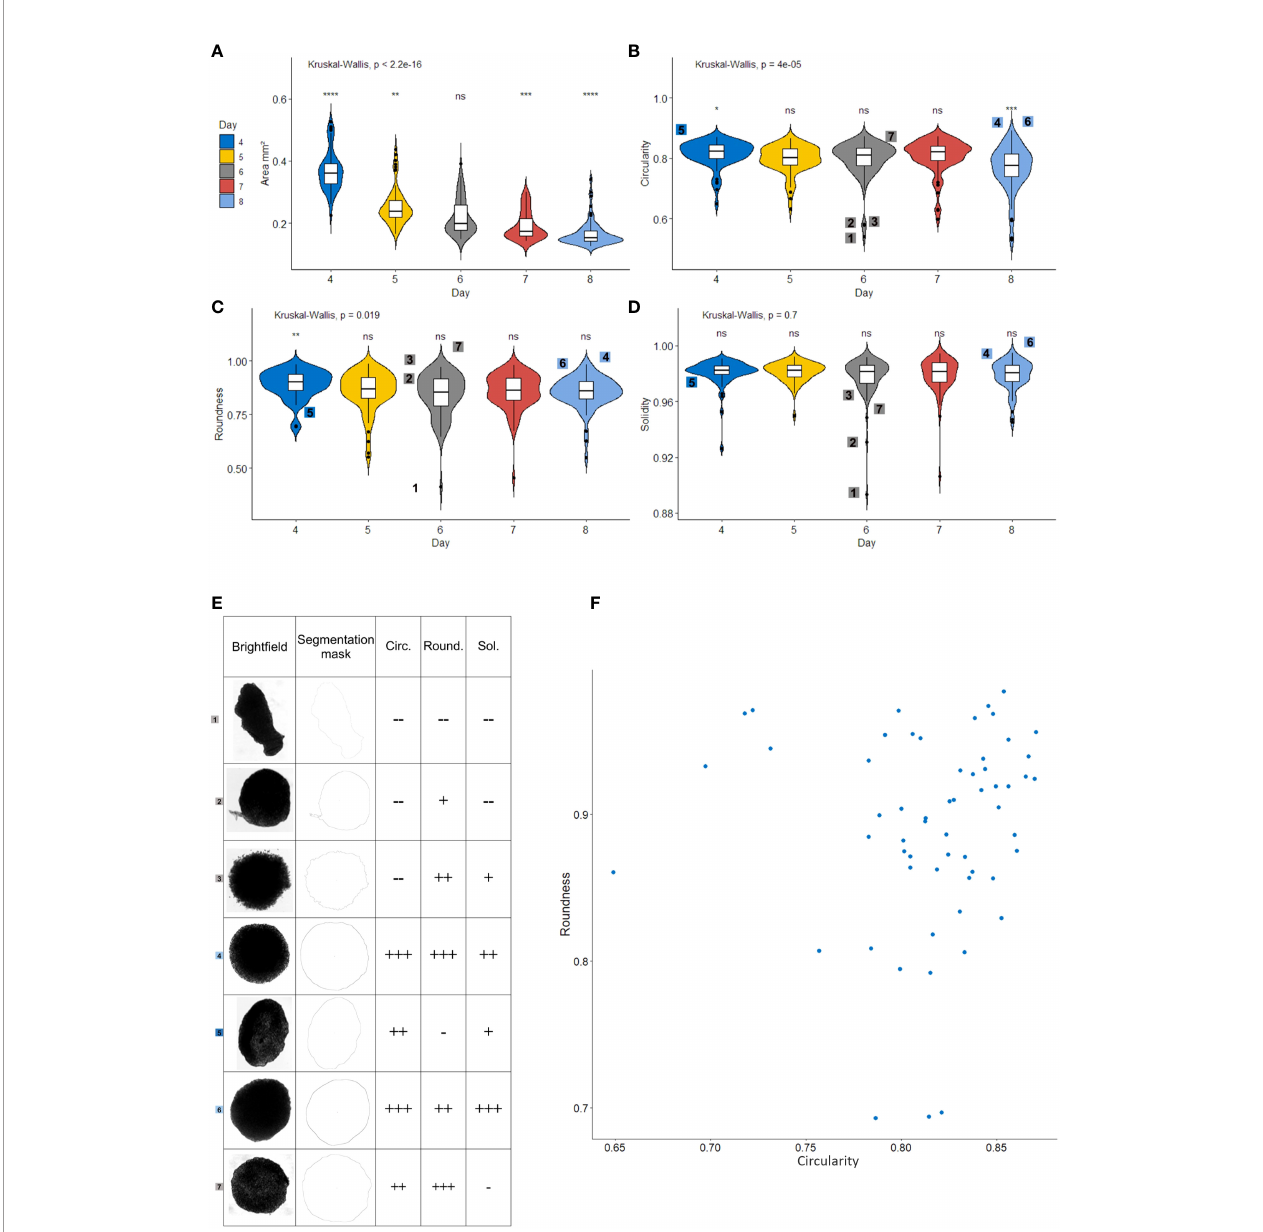
FIGURE 3 | Area, Circularity and Roundness are relevant morphological parameters for selecting a homogeneous spheroid population. Measurement of area (A) , circularity (B) , roundness (C) and solidity (D) of Renal Cell Carcinoma cell line Spheroids (N=70) with a recorded Fiji macro. Violin-plots show box-and-whisker plots (white) representing the 1st and 4th quartiles, the line in the middle denotes the median. Whiskers notify the min and max values. The violin part represents the density plot for each group. Digits on the plot relate to the spheroids shown in (E) , global Kruskal-Wallis test is given above the chart and pairwise Wilcoxon-Mann-Whitney tests represented above each group, comparing the group to every other (base). (E) Illustrative spheroids for roundness, solidity and circularity. Bright fi eld images, ImageJ masks and levels of measured parameters ( – , -, +, ++, and +++). Each of these spheroids is identi fi ed with a digit on other graphs. (F) Roundness and circularity scatter- plot of the entire spheroid population. all parameters calculated with Fiji software. *p < 0.05; **p < 0.01; ***p < 0.001; ****p < 0.0001; ns, non-signi fi